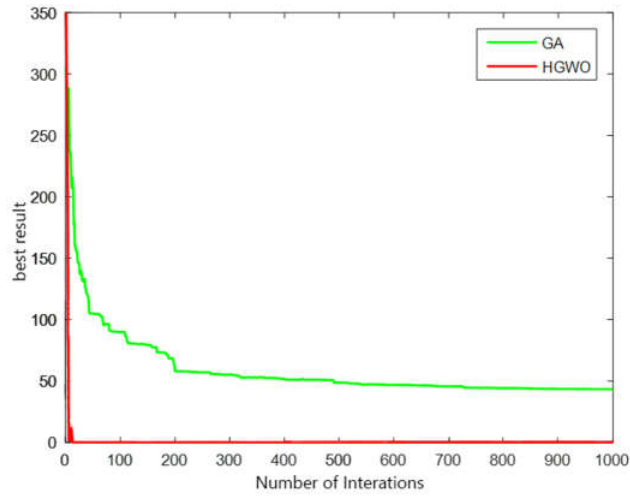
Figure 10. Rastrigin function—objective function value vs. iteration number.